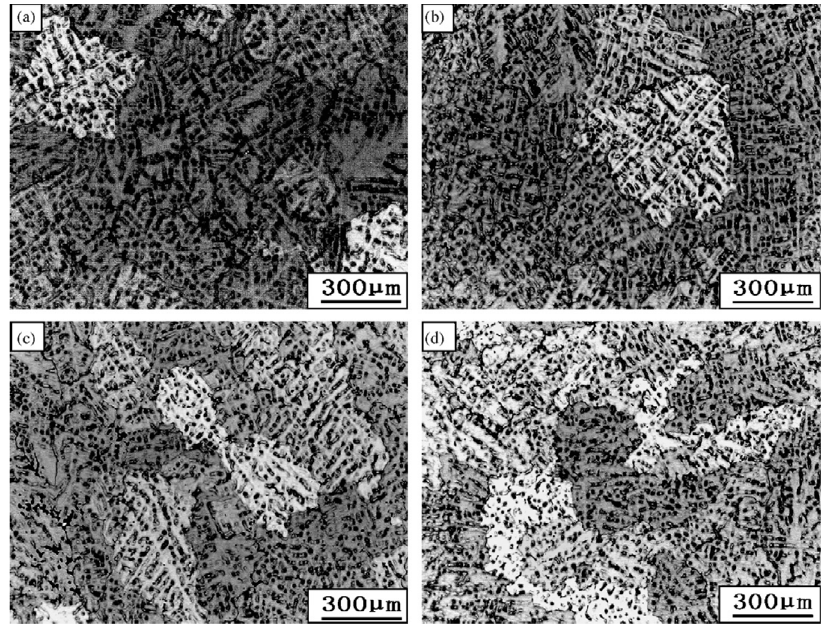
Figure 7. OM microstructure of as-cast Al-Mg-Mn-Zr-Er alloy [27]: ( a ) 0Er, ( b ) 0.2 wt.%Er, ( c ) 0.4 wt.%Er, ( d ) 0.6 wt.%Er. Reprinted with permission from [27], 2009, Elsevier.